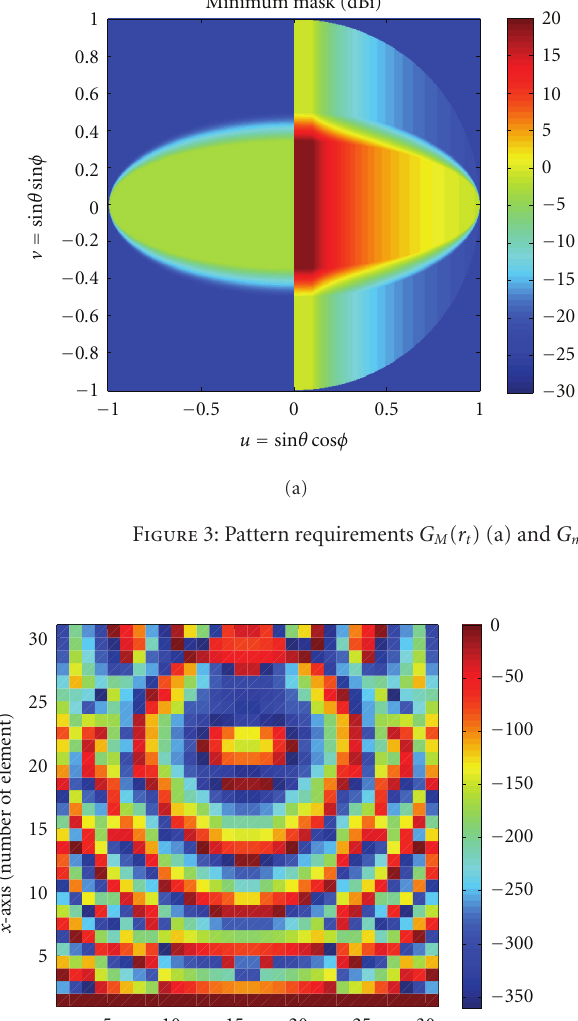
Figure 4: Synthesized phase distribution of the reflection coe ffi - cient for the X R -polarization